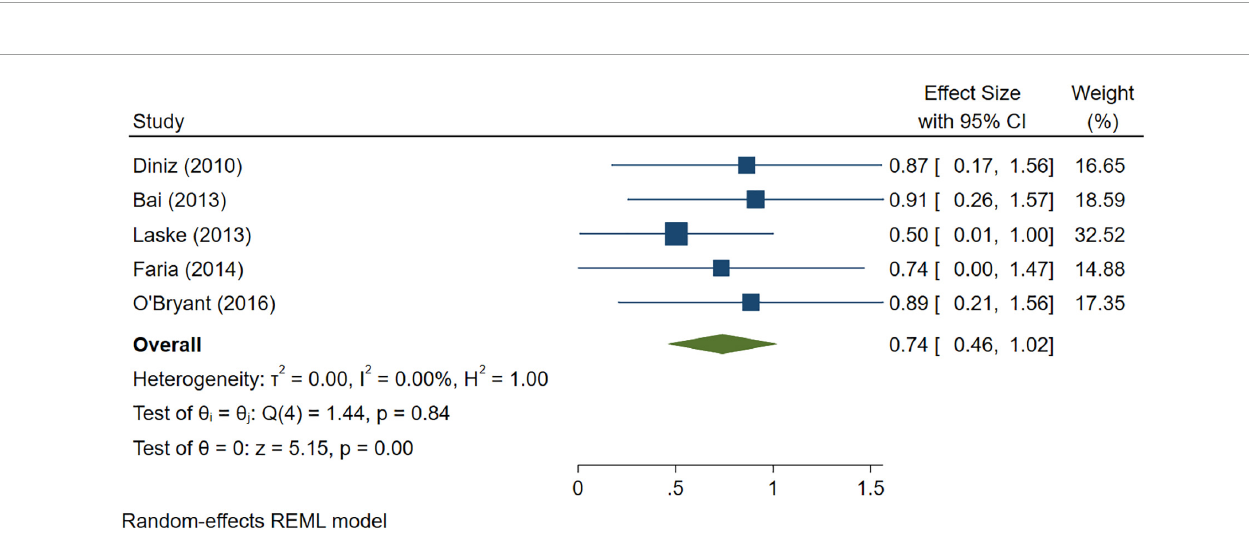
FIGURE6 Forest plot of pooled Hedge’s g depicting high sTNFR-1 concentration in Alzheimer’s disease (AD) samples compared to